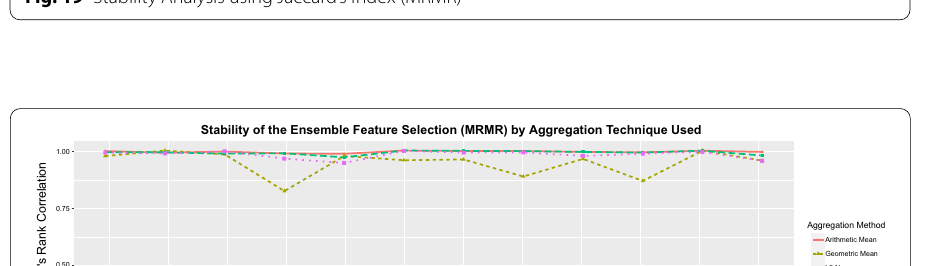
Fig. 19 Stability Analysis using Jaccard’s Index (MRMR)